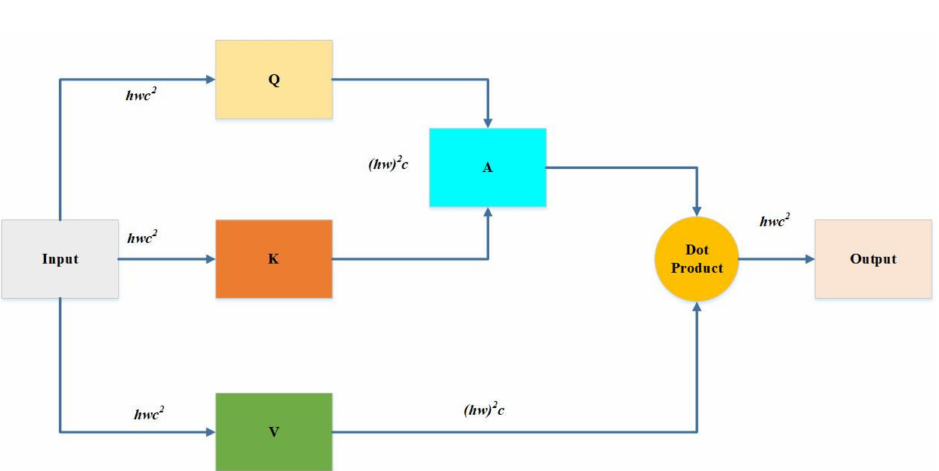
Figure 5. The computational cost of MSA and W-MSA . MSA is calculated according to Equation (3). W - MSA is calculated according to Equation